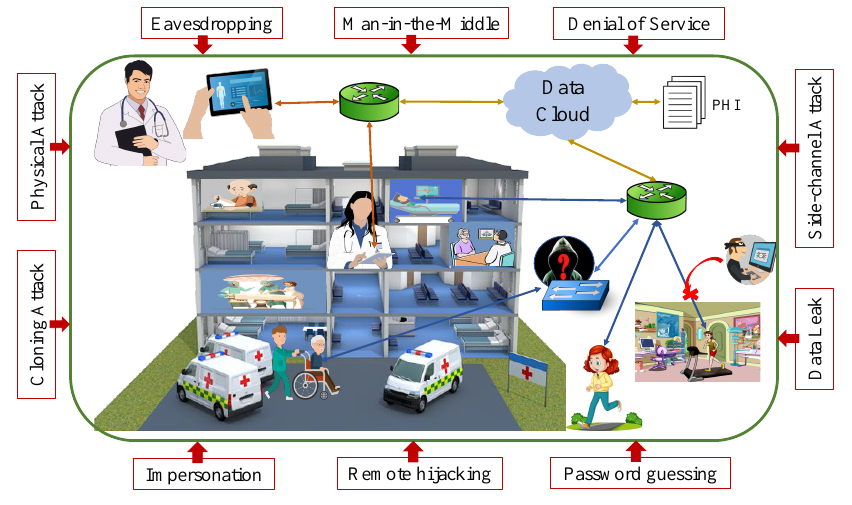
Figure 1. Security threats to an IoMT